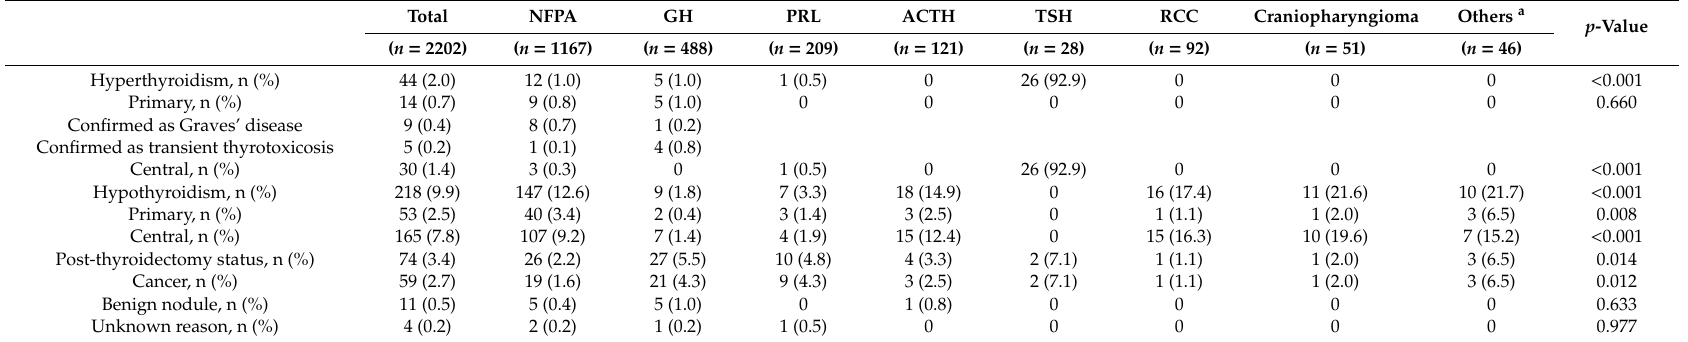
Table 3. Prevalence of thyroid disease according to the type of pituitary